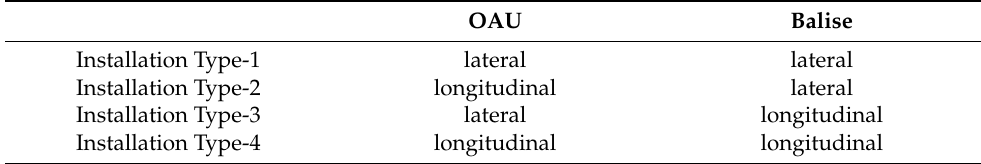
Table 5. Definition of installation